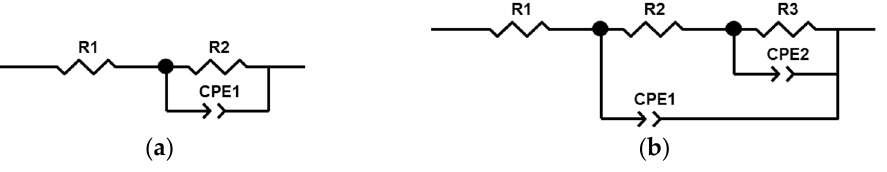
Figure 10. Equivalent circuits used for the EIS results fitting: ( a ) Zr substrate; ( b ) PEO-coated samples. Table 9. EIS fit results of the parameters of the equivalent circuits for the uncoated and PEO-coated samples tested in Ringer’s